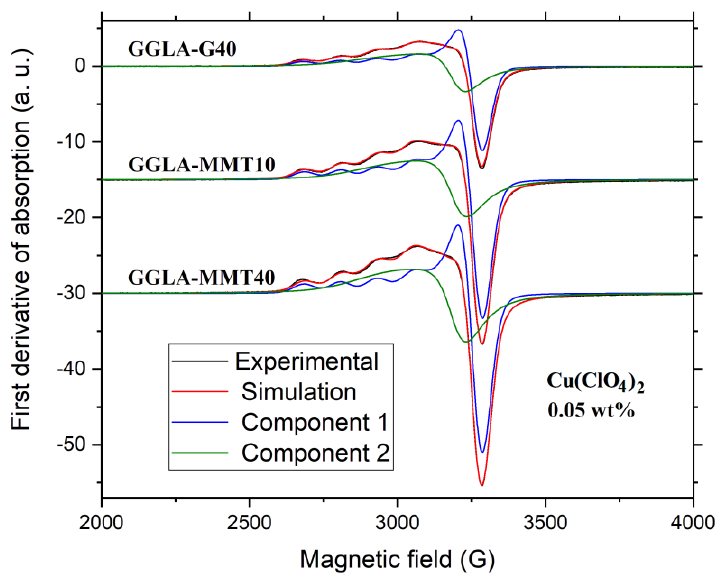
Figure 8. Experimental and simulated EPR spectra of the samples with 0.05 wt.% of Cu(ClO 4 ) 2 . All spectra were measured at the same experimental conditions and normalized to the sample mass. The microwave frequency was ≈ 9.43 GHz. Table 7. Spin Hamiltonian parameters of the samples with 0.05 wt.% of Cu(ClO 4 ) 2 , obtained from the simulation of the experimental EPR spectra. The values of A and strains HS are given in MHz. Gaussian (G) or Lorentzian (L) isotropic line width lwpp are given in mT. (The accuracy of deter- mination of EPR parameters was estimated to be ± 0.005 for g values and ± 6 MHz for hyperfine splitting